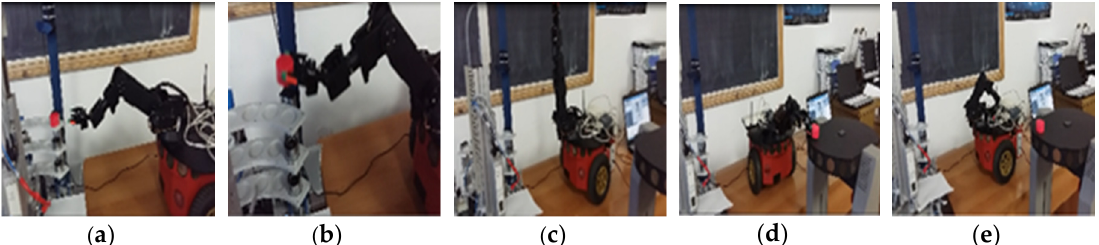
Figure 13. Real-time control of ARS Pioneer 3-DX equipped with RM Pioneer 5-DOF corresponding to the sequences: ( a ) picking up the work-piece from P / RML; ( b – d ) transport using sliding-mode control; ( e ) releasing it on ARS PeopleBot.